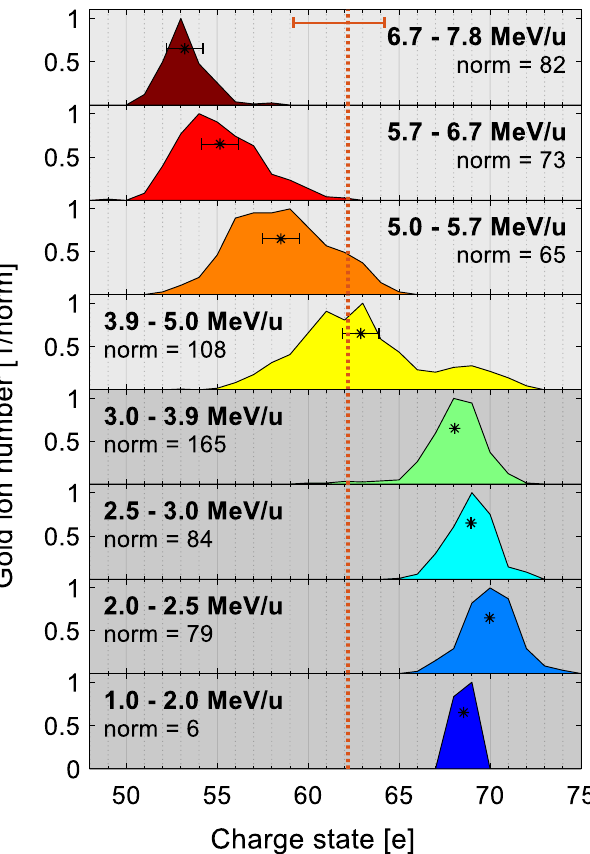
Figure 10. Energy-dependent gold ion charge-state distributions for a shot on a heated, 100 nm thick gold foil. The energies are increasing from the bottom to the top, which is also visualized by the face colors of the distributions (blue means low, red means high energy). The ion numbers of each distribution were normalized to their respective maximum, which is stated for each panel individually (‘norm = X’). The respective mean value has been marked by an asterisk (*) for each charge-state distribution. The error bars in the four topmost panels indicate the charge-state resolution within the shown distribution. The total charge state mean value, averaged over all kinetic energies, is indicated by the dotted, orange line. In the topmost plot, the uncertainty of the charge-state range itself is indicated by the orange error bar.